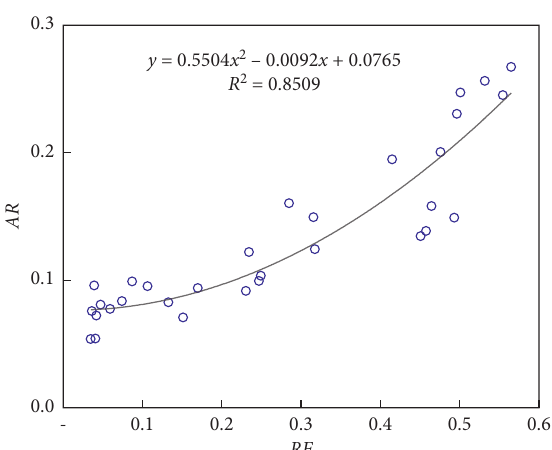
Figure 7: Relationship between RF and AR